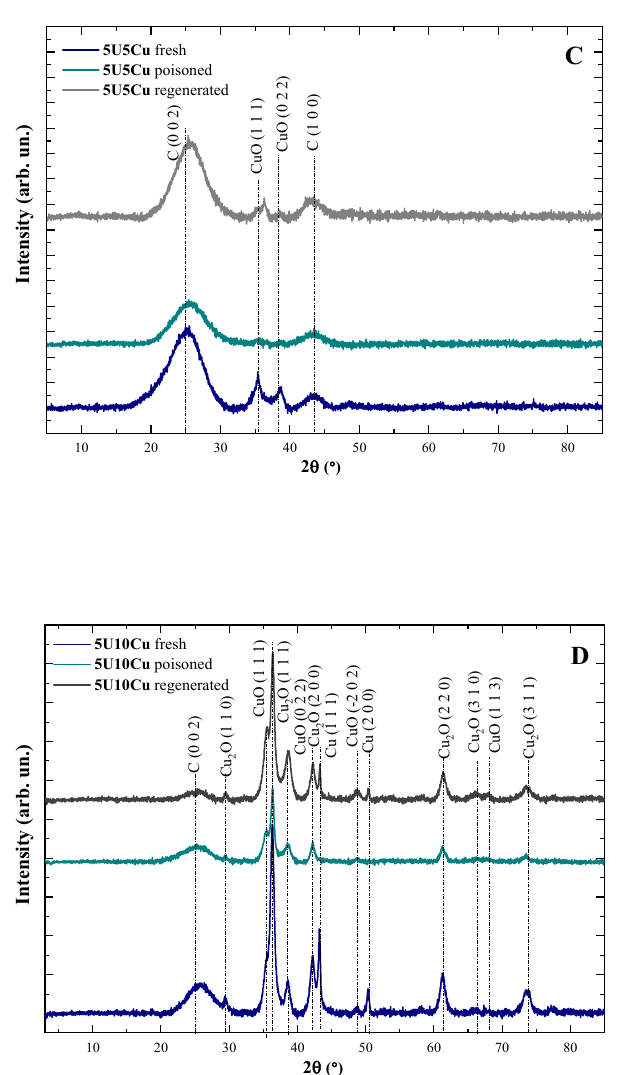
Figure 1. X-ray di ff raction patterns of fresh, poisoned and regenerated: ( A ) 5U; ( B ) 5U1Cu; ( C ) 5U5Cu; ( D ) 5U10Cu.